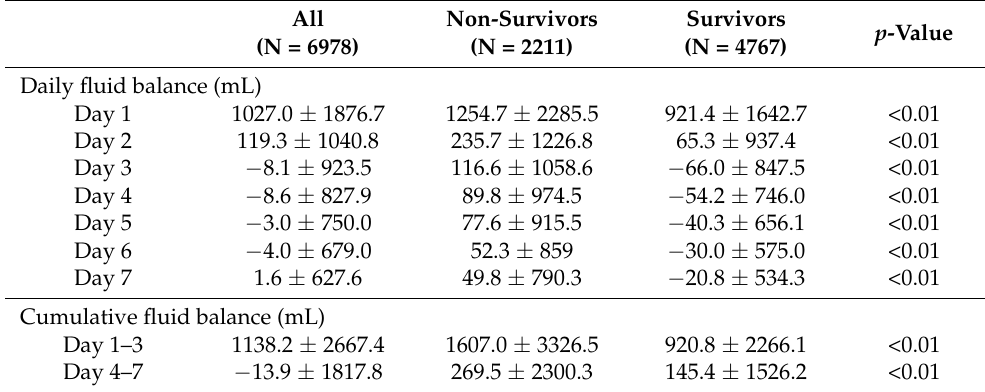
Table 2. Daily and cumulative 1–3 and 4–7 fluid status of the 6978 critically ill surgical patients categorised by